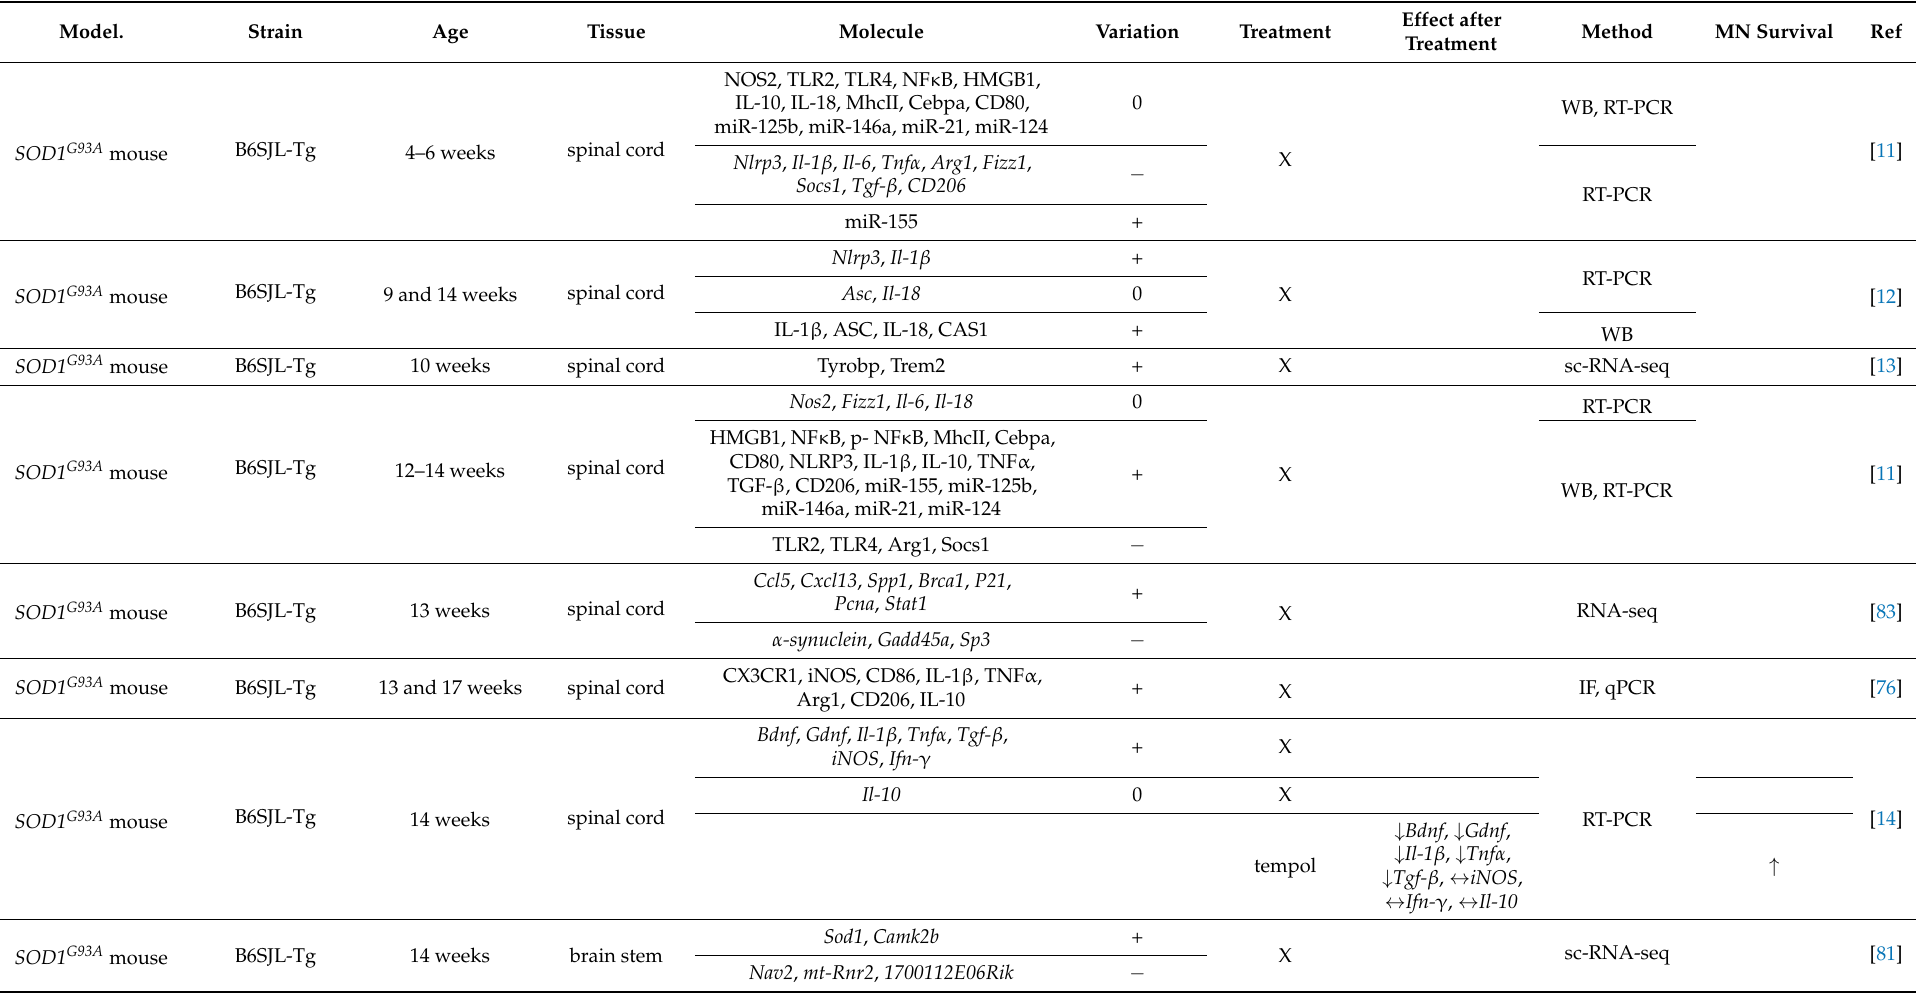
Table 2. Microglial alterations in different SOD1 animal models based on the age, tissue and